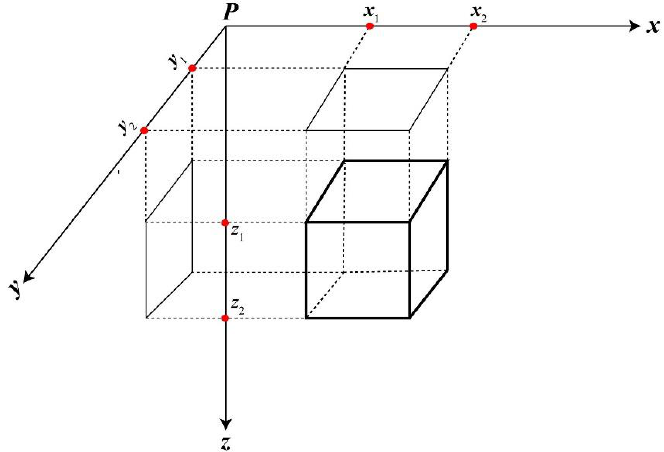
Figure 4. Definition of a prism mass body.